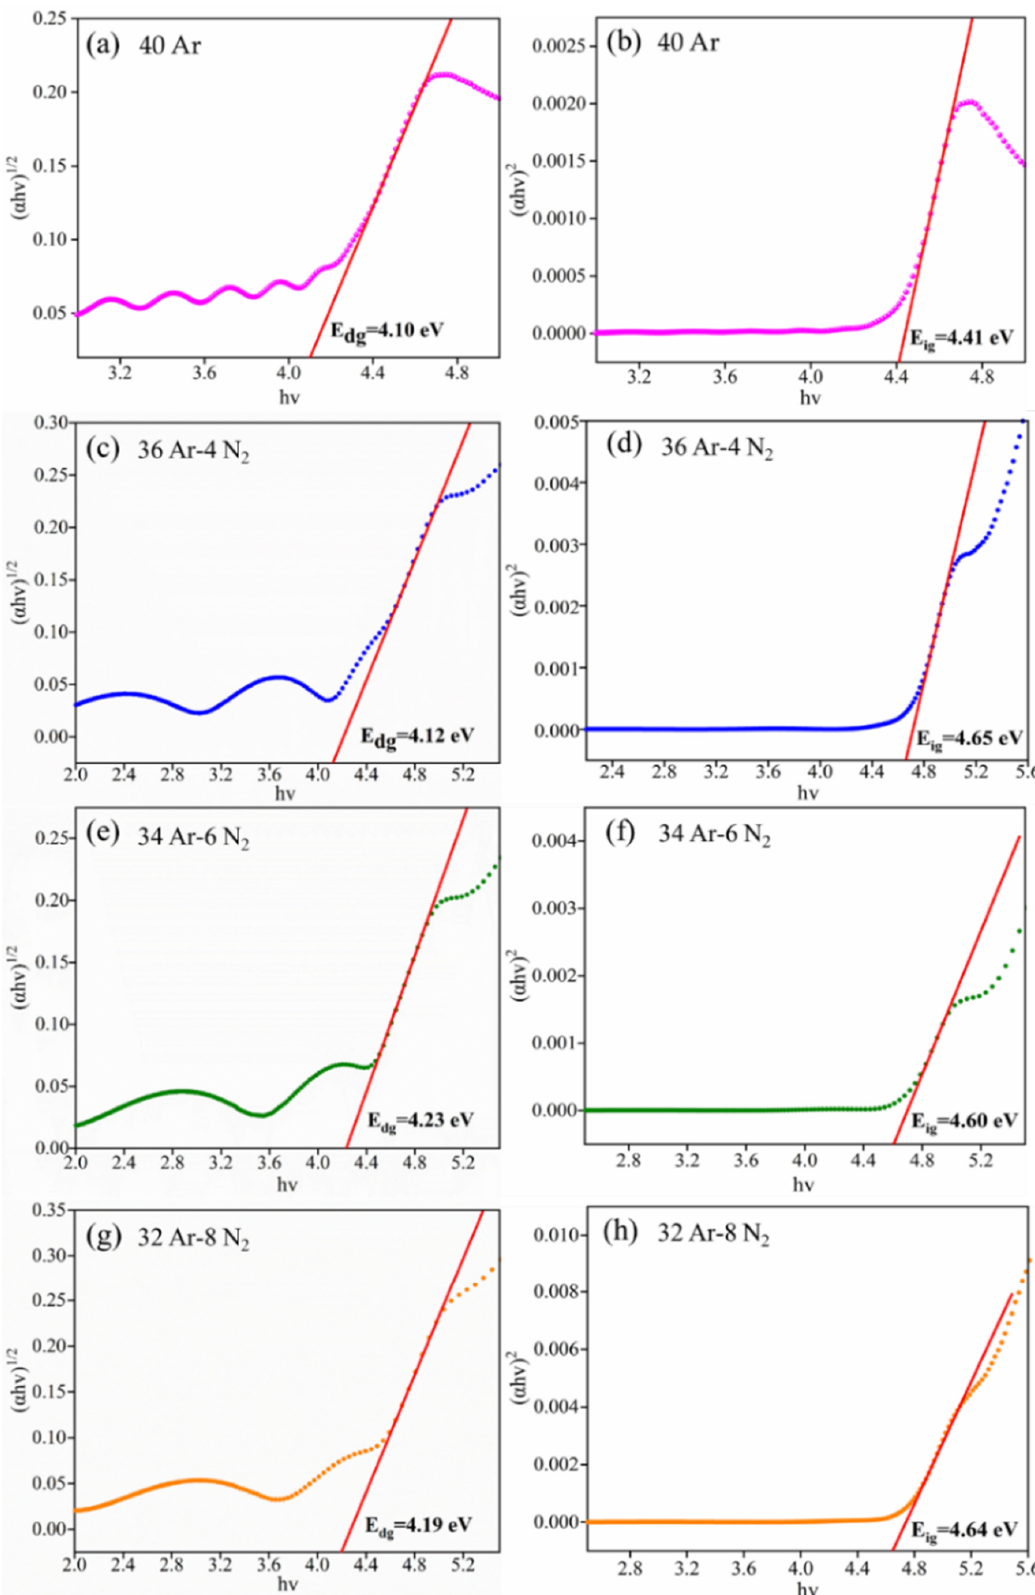
Figure 7. Optical band gap of Ta 2 O 5 coatings prepared at different N 2 and Ar gas flow rates with a sputtering power of 140 W. ( a,b ) 40Ar, ( c,d ) 36Ar-4N 2 , ( e,f ) 34Ar-6N 2 , ( g,h ) 32Ar-8N 2 .